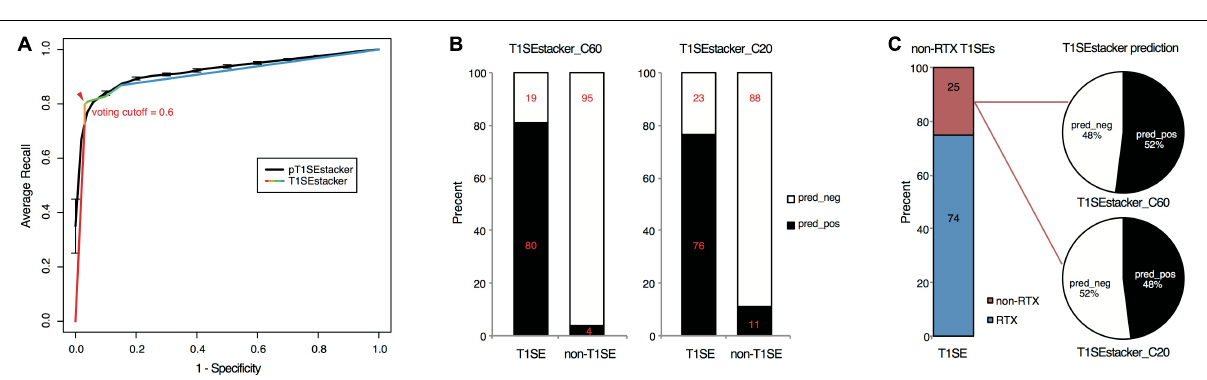
FIGURE 6 | Prediction performance of T1SEstacker on experimentally verified T1SEs and the paired non-T1SEs. (A) ROC curves of the final T1SEstacker_C60 and the primary pT1SEstacker_C60 models on prediction of experimentally verified T1SEs and the paired non-T1SEs. The number for both T1SEs and non-T1SEs was 99. The best-optimized cutoff for the decision of T1SEstacker is indicated with a red arrow. (B) The recalling T1SEs and false-positive T1SE predictions of T1SEstacker_C60 and T1SEstacker_C20. (C) The T1SE proteins without putative RTX motifs (non-RTX T1SEs) and the correctly predicted percent of T1SEstacker on